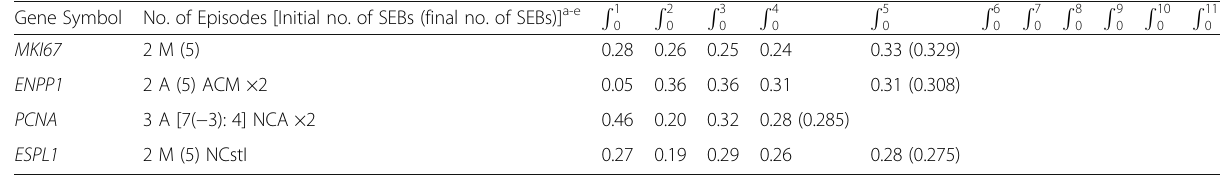
Table 16 ( − ) and (+) strand chromatin MKI67 , ENPP1 , PCNA and ESPL1 cell proliferation marker gene sequential esebssiwaagoT Q s to final 2-digit (and 3-digit) esebssiwaagoT